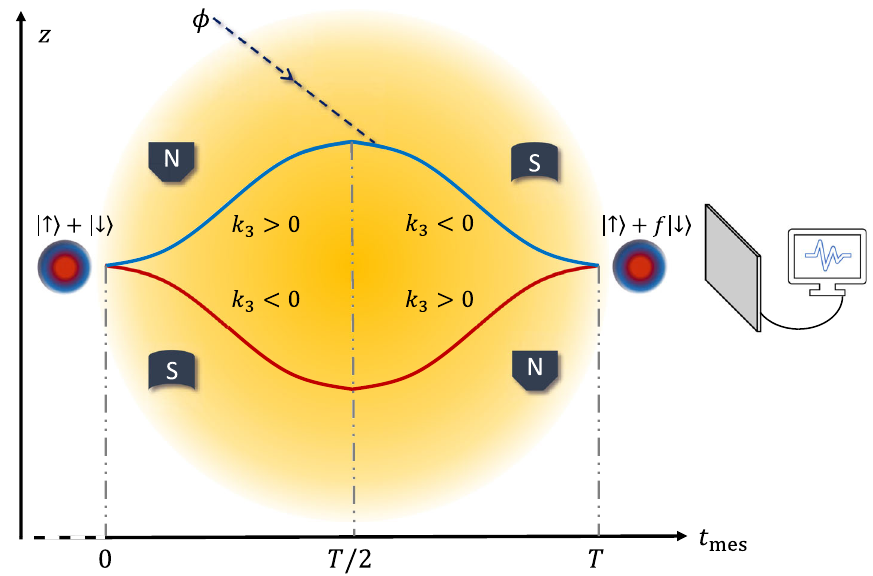
Fig. 2 The scheme of the experimental setup over t mes , in which k 3 is the third component of the momentum of neutral atoms. The blue- red circle illustrates the superposition of two neutral atom states at the beginning and end of the process. One of two states,i.e., the up state, proceeds in the upper loop with a blue line, and the other, the down state, moves in the lower path with a red line. Due to the effect of the